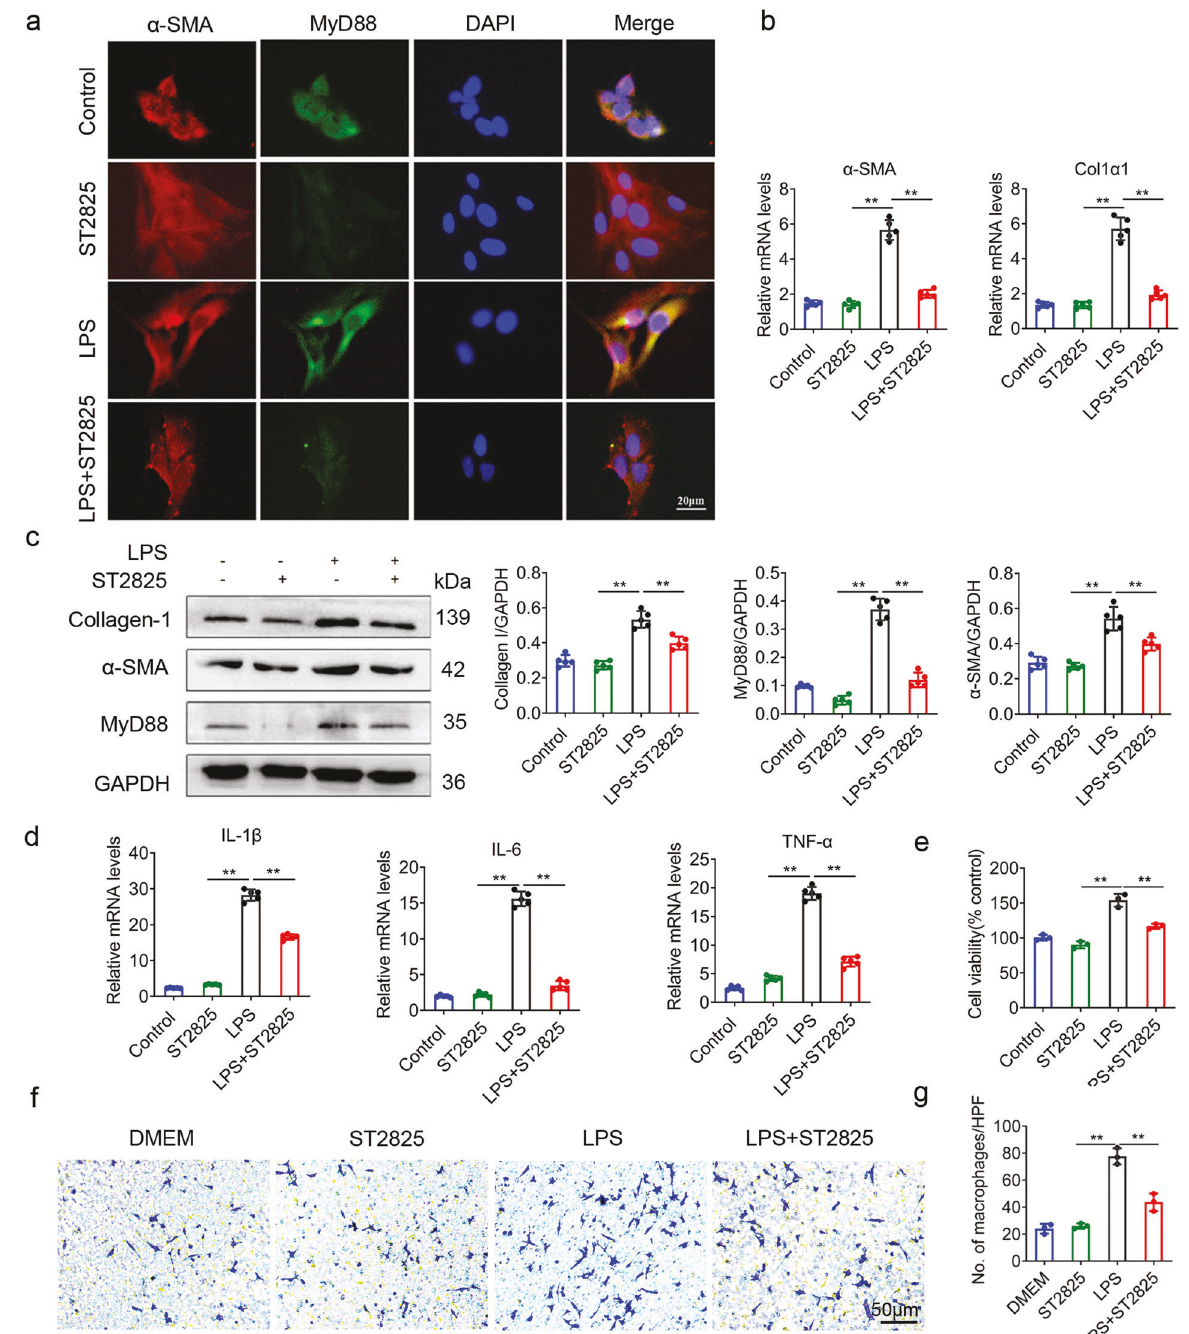
Fig. 4 Inhibition of MyD88 attenuates the activation and in fl ammatory response of hepatic stellate cells. LX-2 cells were activated with LPS (100 ng/mL) and incubated with MyD88 inhibitor ST2825 (20 μ M) for 24 h. a Immuno fl uorescence staining for α -SMA (red) and MyD88 (green) in LX-2 cells. Scale bar, 20 μ m. b The mRNA levels of activation-related genes α -SMA, Col1 α 1 in LX-2 cells were measured using qPCR analysis, * p < 0.05, ** p < 0.01. c The protein levels of MyD88, α -SMA and collagen I in LX-2 cells were detected by Western blot. The densities of proteins were quanti fi ed by densitometry. α -SMA and MyD88 were normalized to GAPDH. * p < 0.05, ** p < 0.01. d The mRNA levels of IL-1 β , IL- 6, and TNF- α in LX-2 cells were detected by qPCR, ** p < 0.01. e CCK8 assay for cell viability. ** p < 0.01. f Chemotactic activity was analyzed to evaluate the role of MyD88 in LX-2 on the migration of macrophages as described in Materials and Methods. Macrophages migrated toward LX-2, ST2825-treated LX-2, LPS-treated LX-2, LPS, and ST2825-treated LX-2 are shown. And the mean numbers of cells migrated through the fi lter per HPF (×400) are shown ( g ). Data were representatives of at least three independent experiments. Scale bar, 50 μ m. ** p < 0.01. These charts show the average of the experimental results, with the error bar showing the standard error of mean.